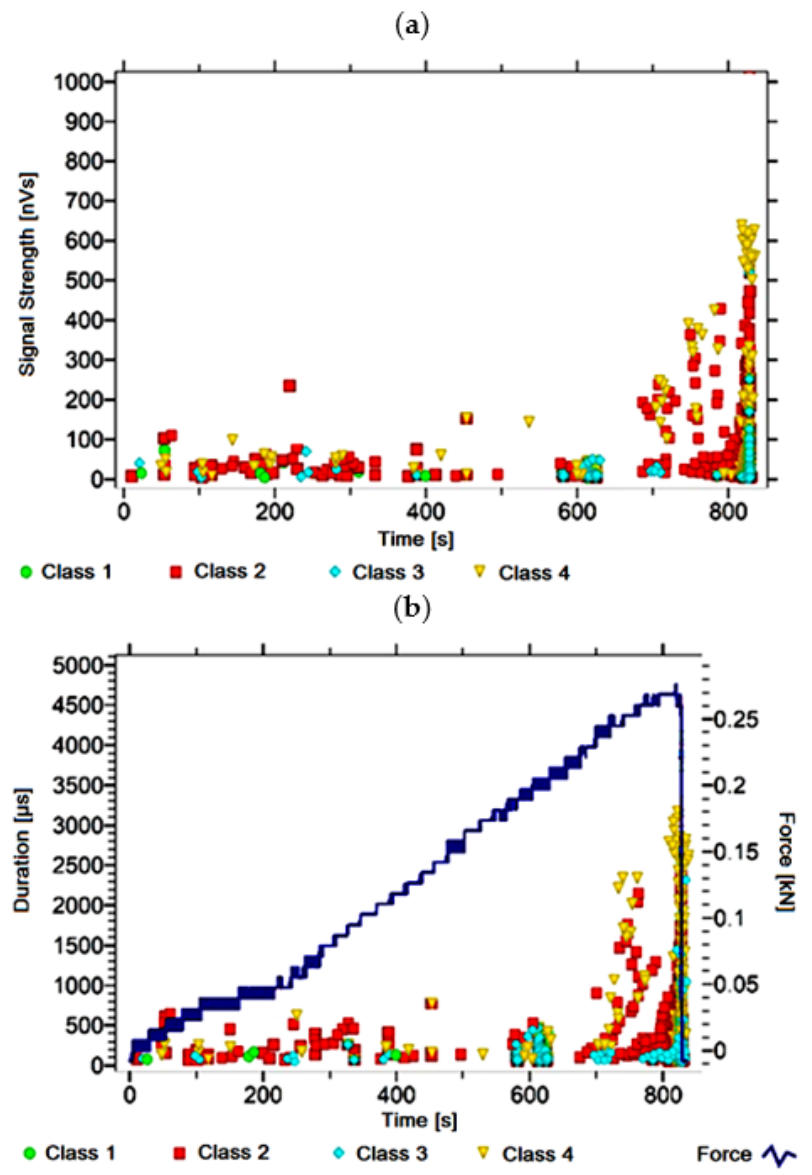
Figure 7. Graphs of acoustic emission signals for an exemplary sample of A 6 series: ( a ) signal strength over time; ( b ) distribution of the duration of the signals over time with the force increment curve.